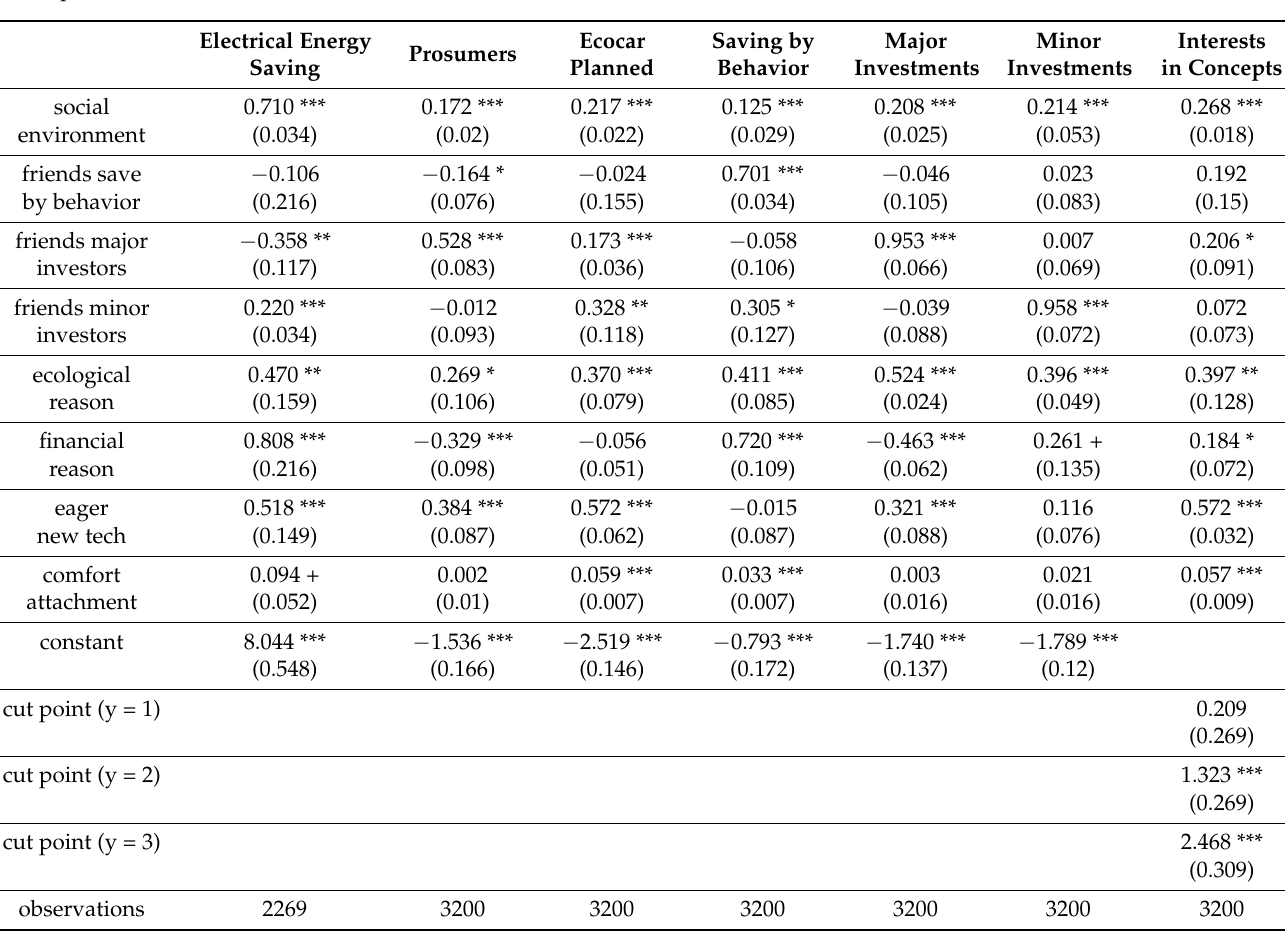
Table 1. Results from the GSEM, part I. Authors’ own analysis, based on data obtained during an online survey performed in four countries. + p < 0.10, * p < 0.05, ** p < 0.01, *** p < 0.001, the standard errors clustered in countries are reported in